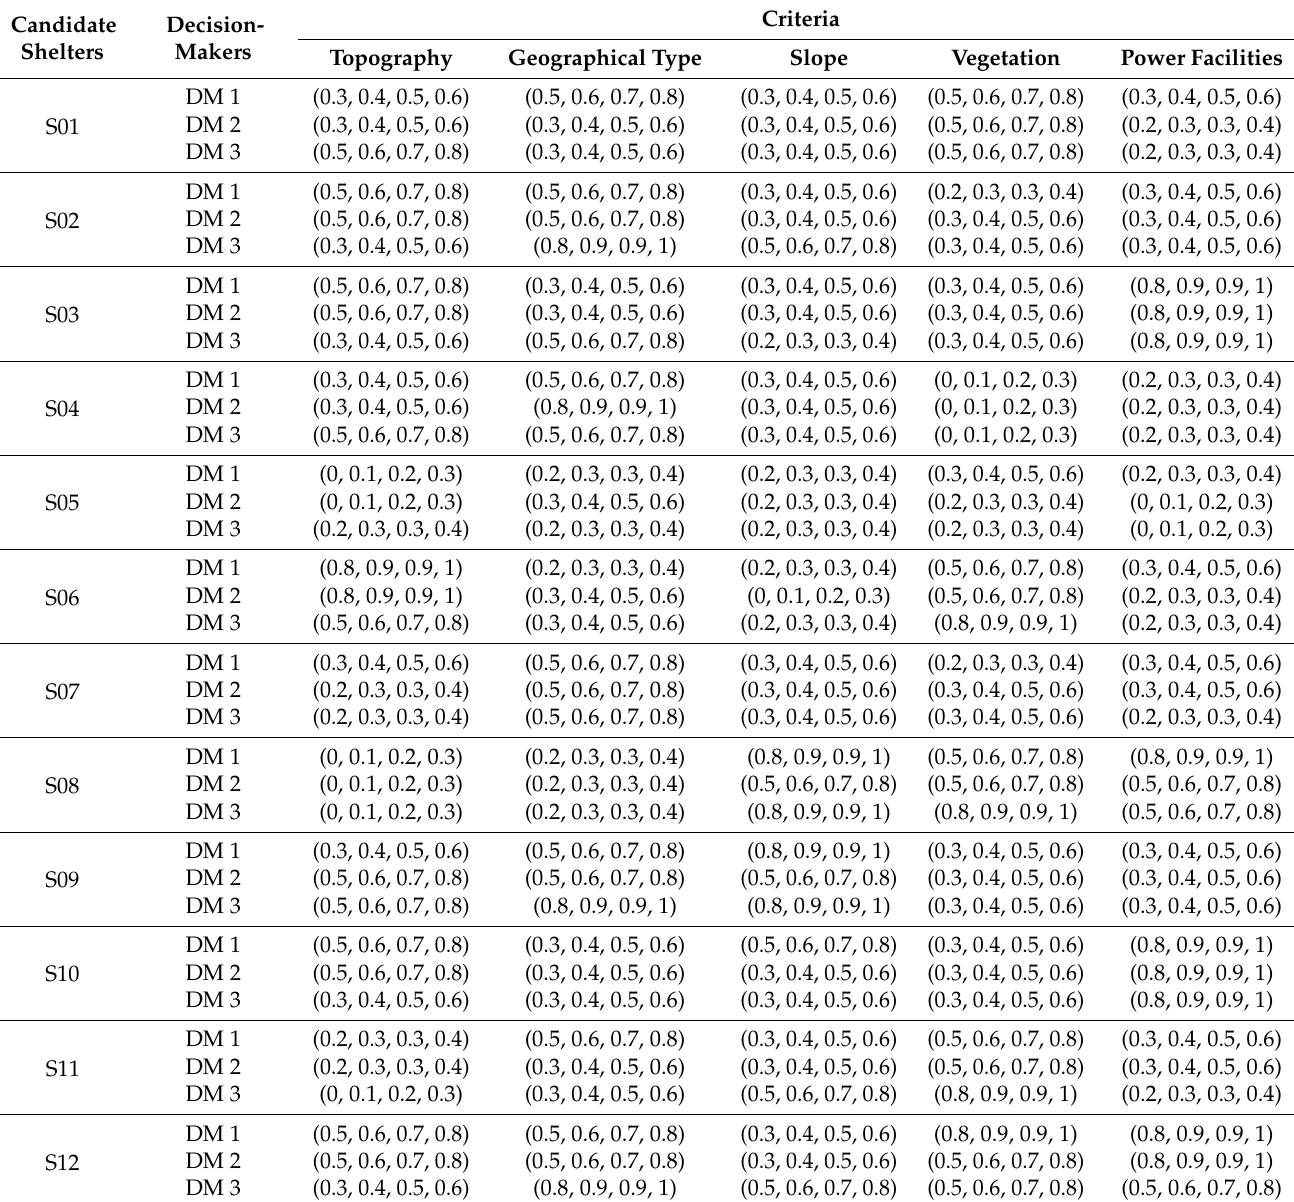
Table 10. Fuzzy values of linguistic terms of candidate